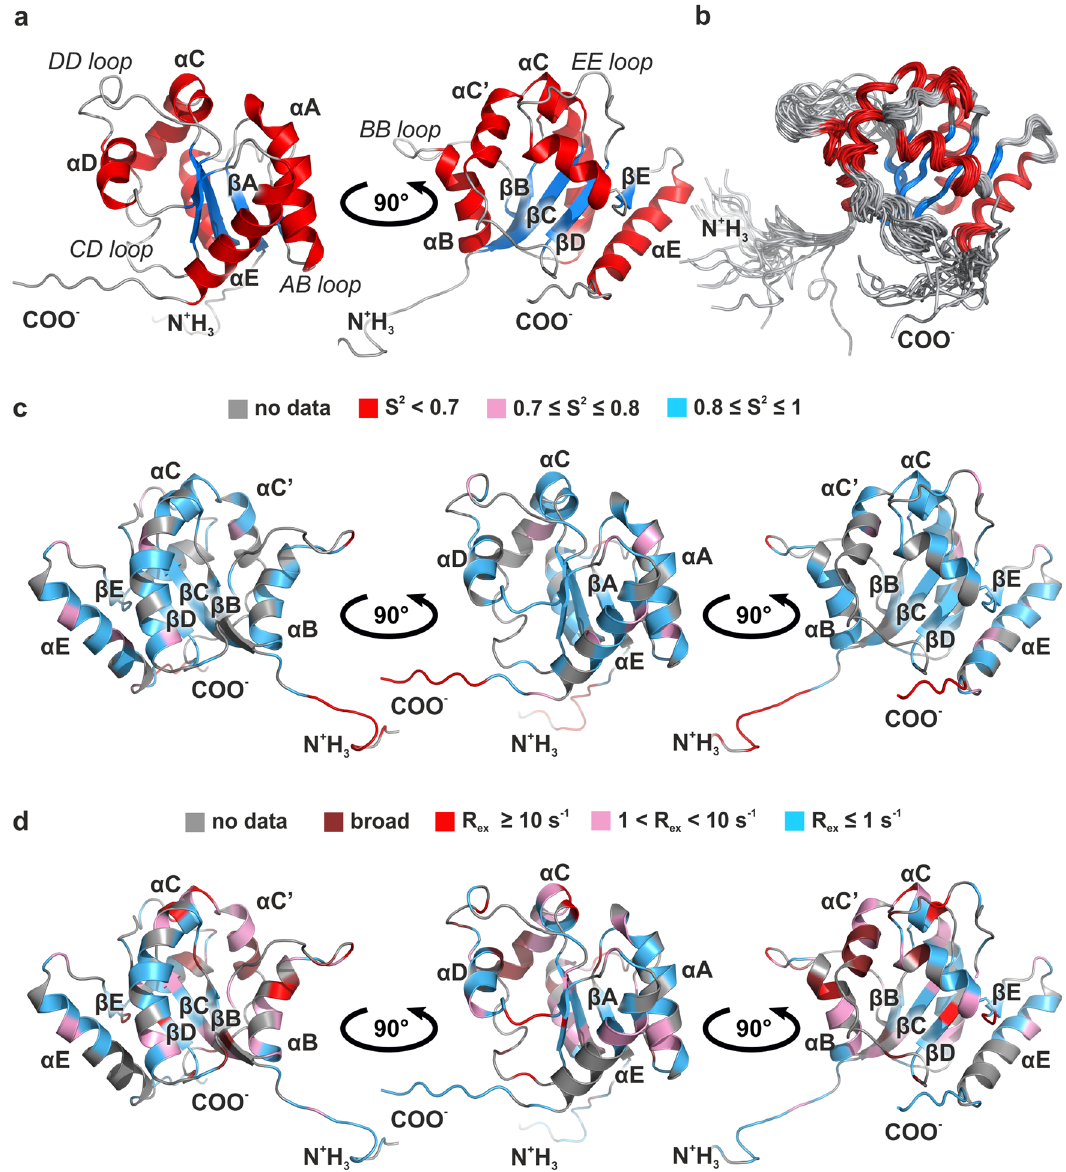
Fig. 1 Spatial structure and dynamics of TLR1-TIR. a Protein structure in ribbon representation. b Twenty best structures of TLR1-TIR, superimposed over the backbone atoms of the secondary structure elements. α -Helices are colored in red, β -sheets are shown in blue, coil regions are shown in gray. c Fast (ps – ns) motions of the protein backbone. Spatial structure of TLR1-TIR is colored with respect to the generalized order parameters of NH bonds. d Slow ( µ s – ms) motions of the protein backbone. Spatial structure of TLR1-TIR is colored with respect to the exchange contribution to the 15 N transverse relaxation. Regions with no relaxation data measured are colored in gray in c and d . α -Helices, loops, and β -sheets of TLR1-TIR are assigned using the conventional nomenclature accepted for the TIR domains. Regions with signals being observed in the spectrum, but with relaxation parameters that cannot be measured reliably due to the excessive line broadening are marked in